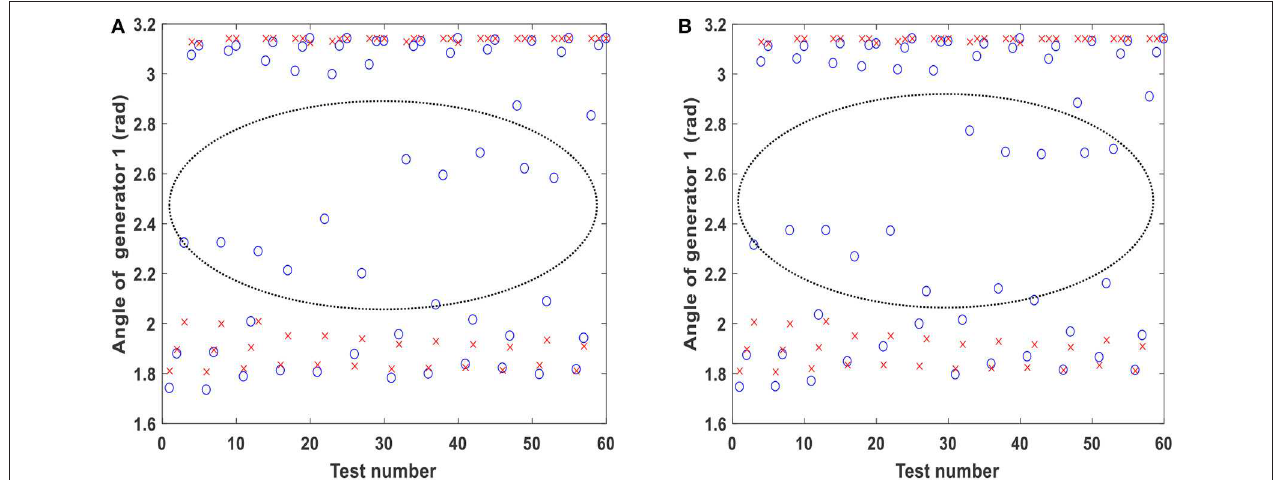
FIGURE 12 | (A) Results with 98 variables; (B) Results with 11 key variables under 65% wind penetration. O = Estimation; X = Simulation.